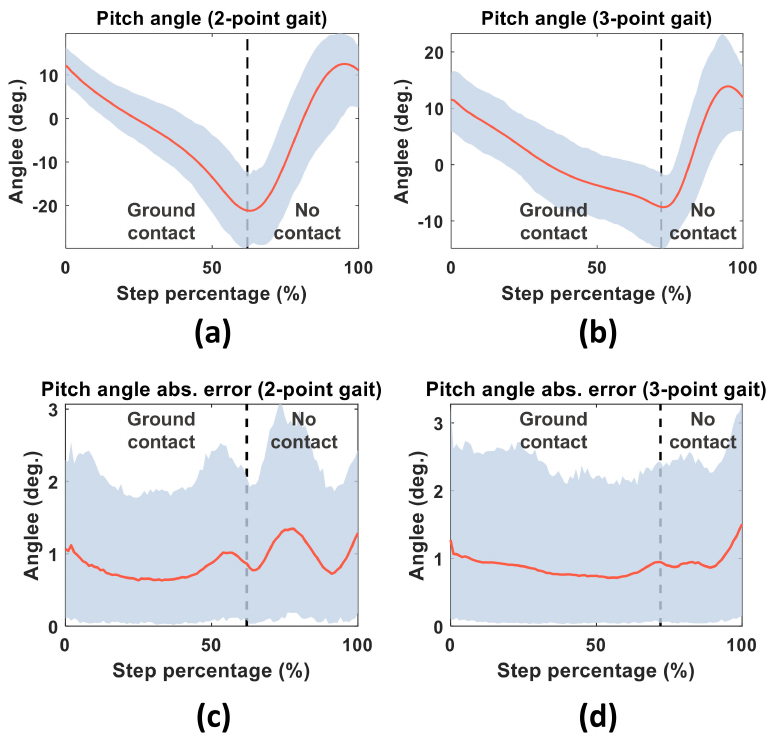
Figure 8. Average pitch values (red curves) and their confidence intervals (blue regions) in the 2-point ( a ) and 3-point ( b ) gaits. Bottom panels show the absolute pitch-angle errors in the 2-point ( c ) and 3-point ( d )